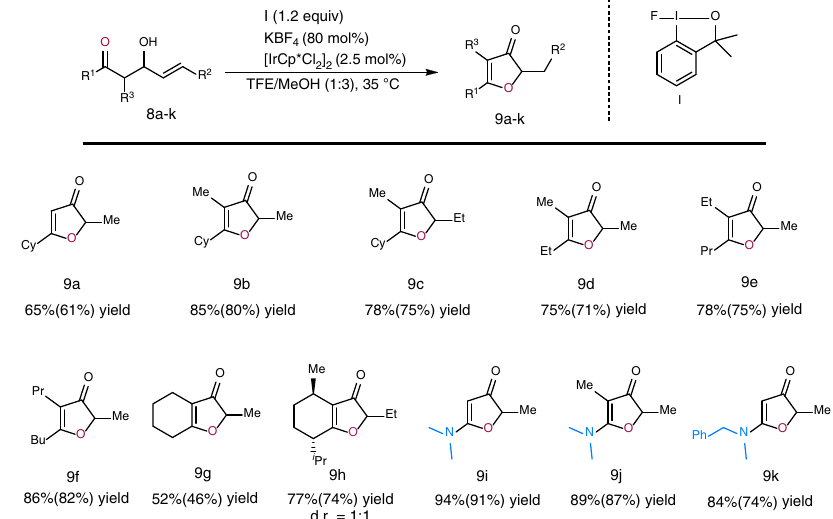
Fig. 4 Scope of allylic alcohols 8 . Yields by 1 H NMR spectroscopy (isolated yields in